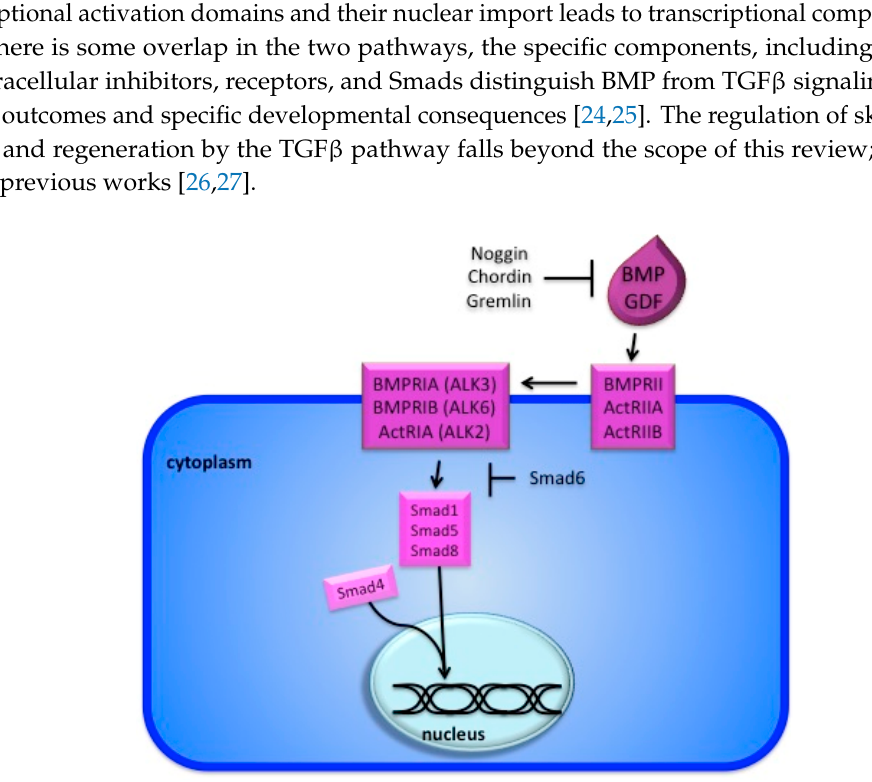
Figure 1. The BMP signaling pathway. Binding of the ligand to the type II receptor recruits the type I receptor and activates Smad 1/5/8 by phosphorylation. The later engages Smad4, which is shared with the TGFb pathway, and the complex translocates to the nucleus to regulate transcription of target genes (e.g. Id). The pathway is blocked by several inhibitors (e.g. Noggin) as well as the inhibitory Smad6.